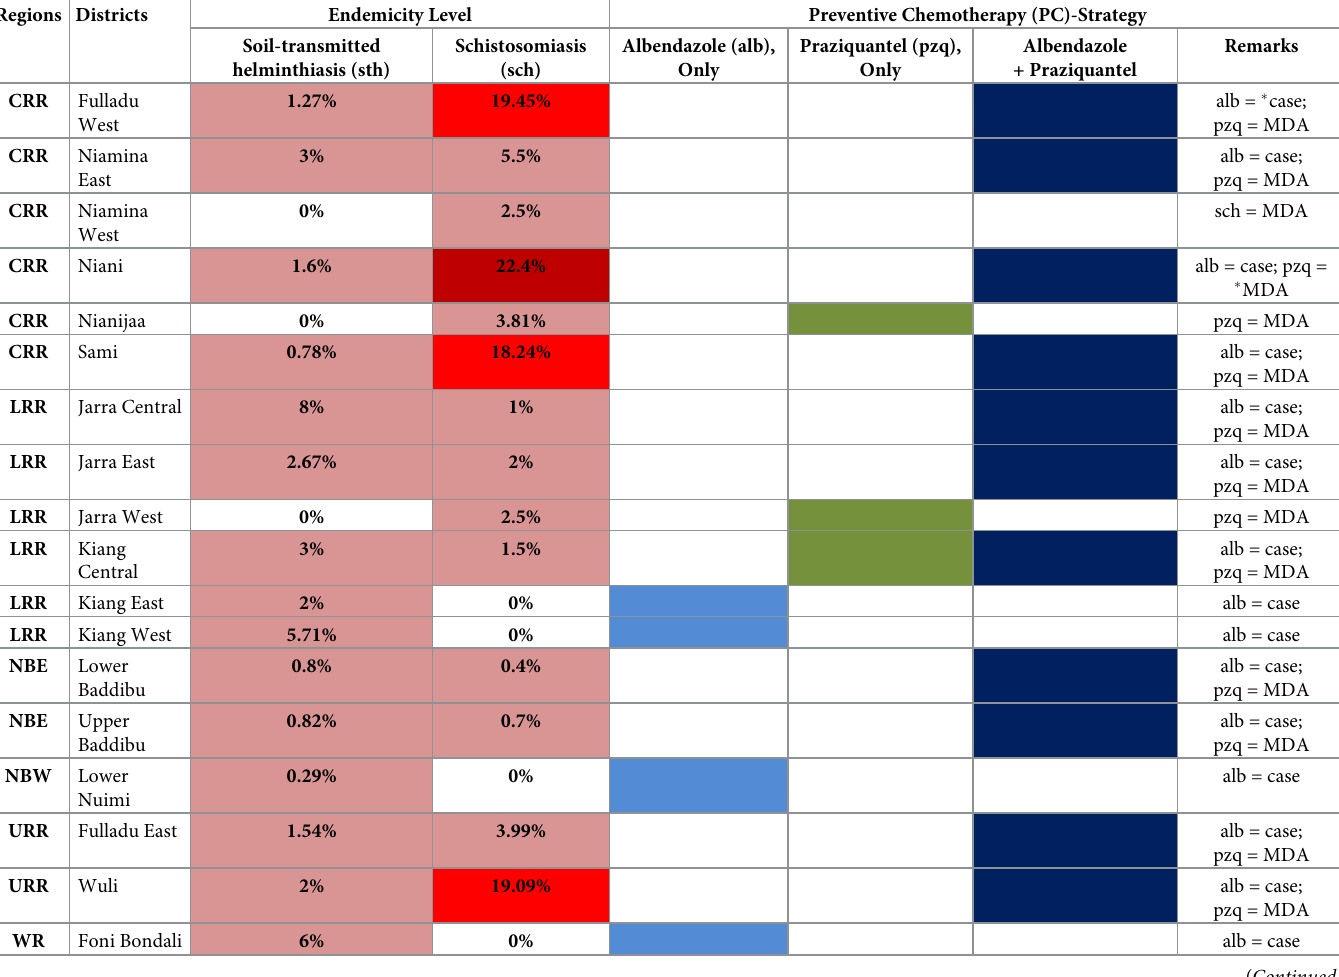
Table 3. Strategy for Preventive Chemotherapy through MDA implementation in 2017 Fiscal Year based on the status of endemicity at district levels. Regions Districts Endemicity Level Preventive Chemotherapy (PC)-Strategy Soil-transmitted Schistosomiasis Albendazole (alb), Praziquantel (pzq), Albendazole helminthiasis (sth) (sch) Only Only +